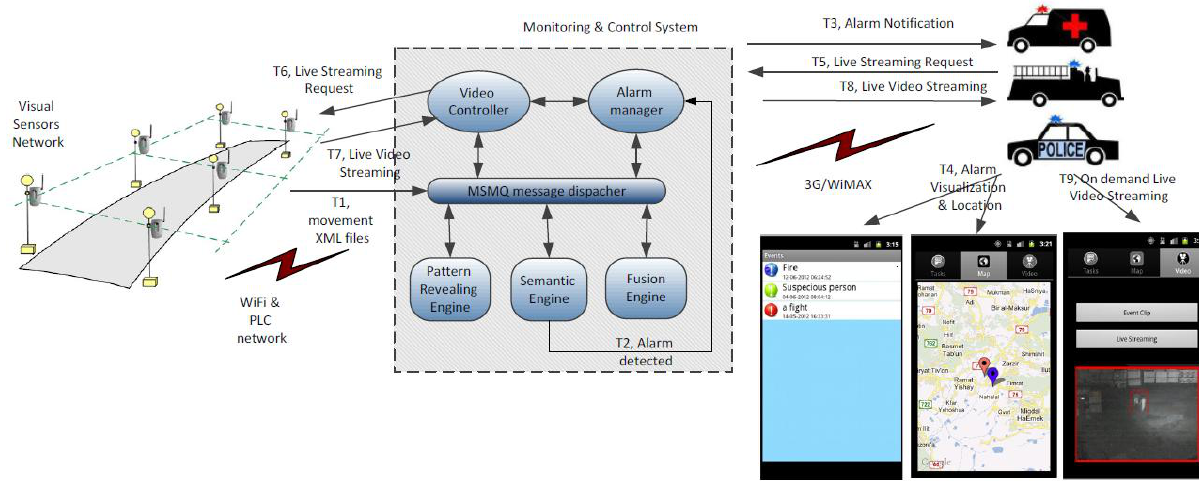
Figure 1. HuSIMS: alarm detection, notification and video streaming request upon alarm